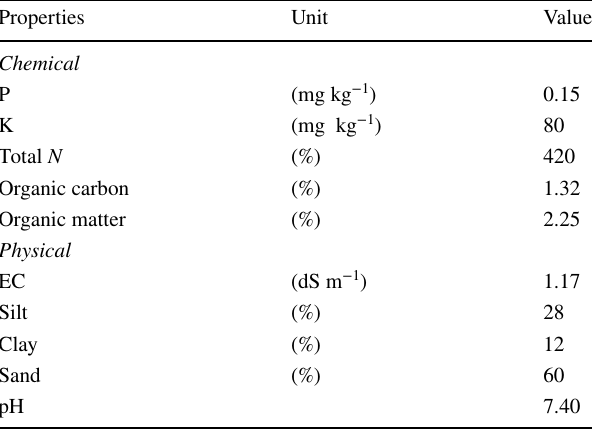
Table 1 Physical and chemical properties of the soil at experimental Properties